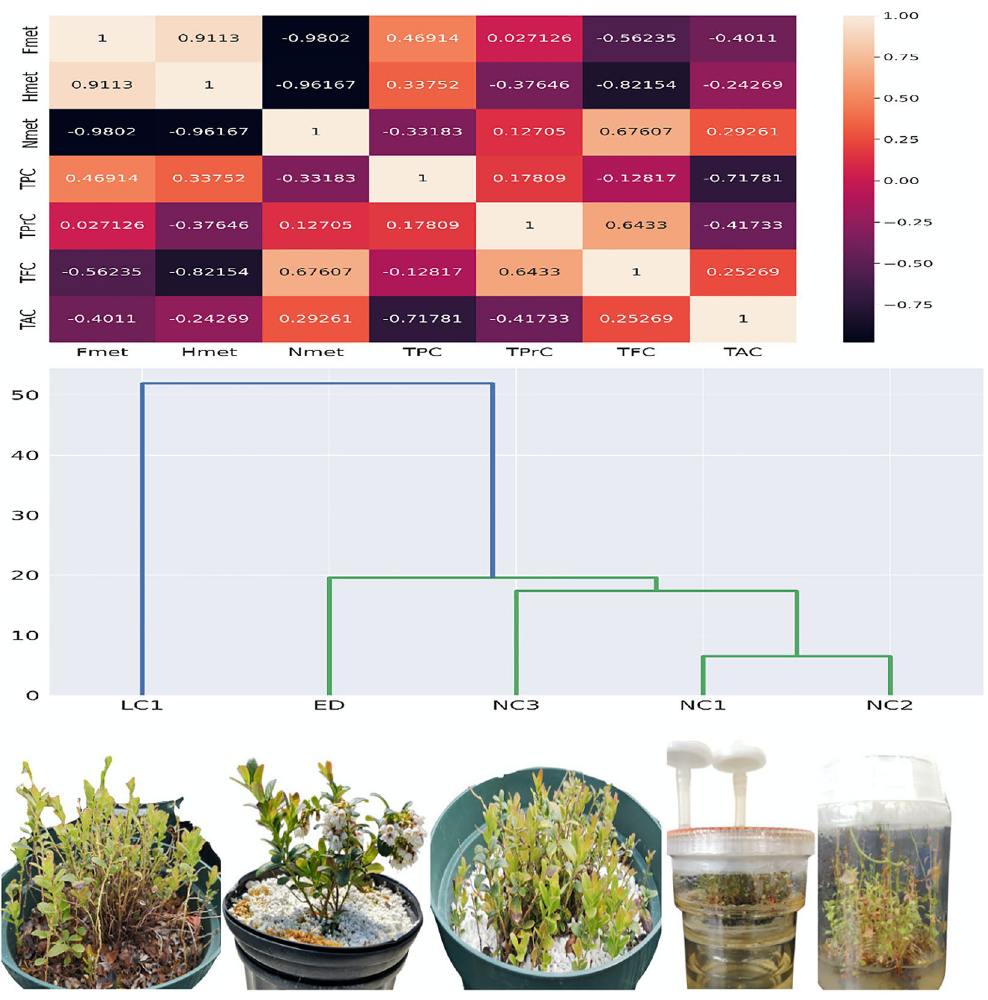
Figure 4. Heatmap represents the partnership between cytosine methylation and secondary metabolites in lingonberry. Dendrogram portraying that node culture-derived in vitro propagated shoots NC1 and NC2 were closely related to node culture-derived greenhouse-grown plant NC3 than those of LC1 and ED. The matplotlib package in Python was used to generate the heatmap. Fmet refers to full-methylation, Hmet refers to hemi- methylation and Nmet refers to non-methylation. TPC = total phenolic content, TFC = total flavonoid content, TPrC = total proanthocyanidin content and TAC = total antioxidant activity. NC1, NC2, NC3 and LC1 are the micropropagated shoots and plants, and ED is cutting propagated plants of lingonberry cultivar Erntedank (more details are in supplementary Table